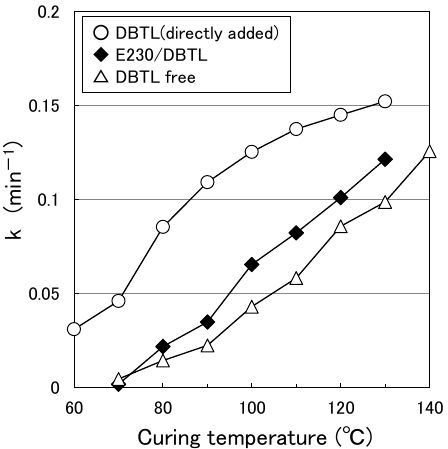
Figure 5. Relationship between k and curing temperature (surfactant: E-230).